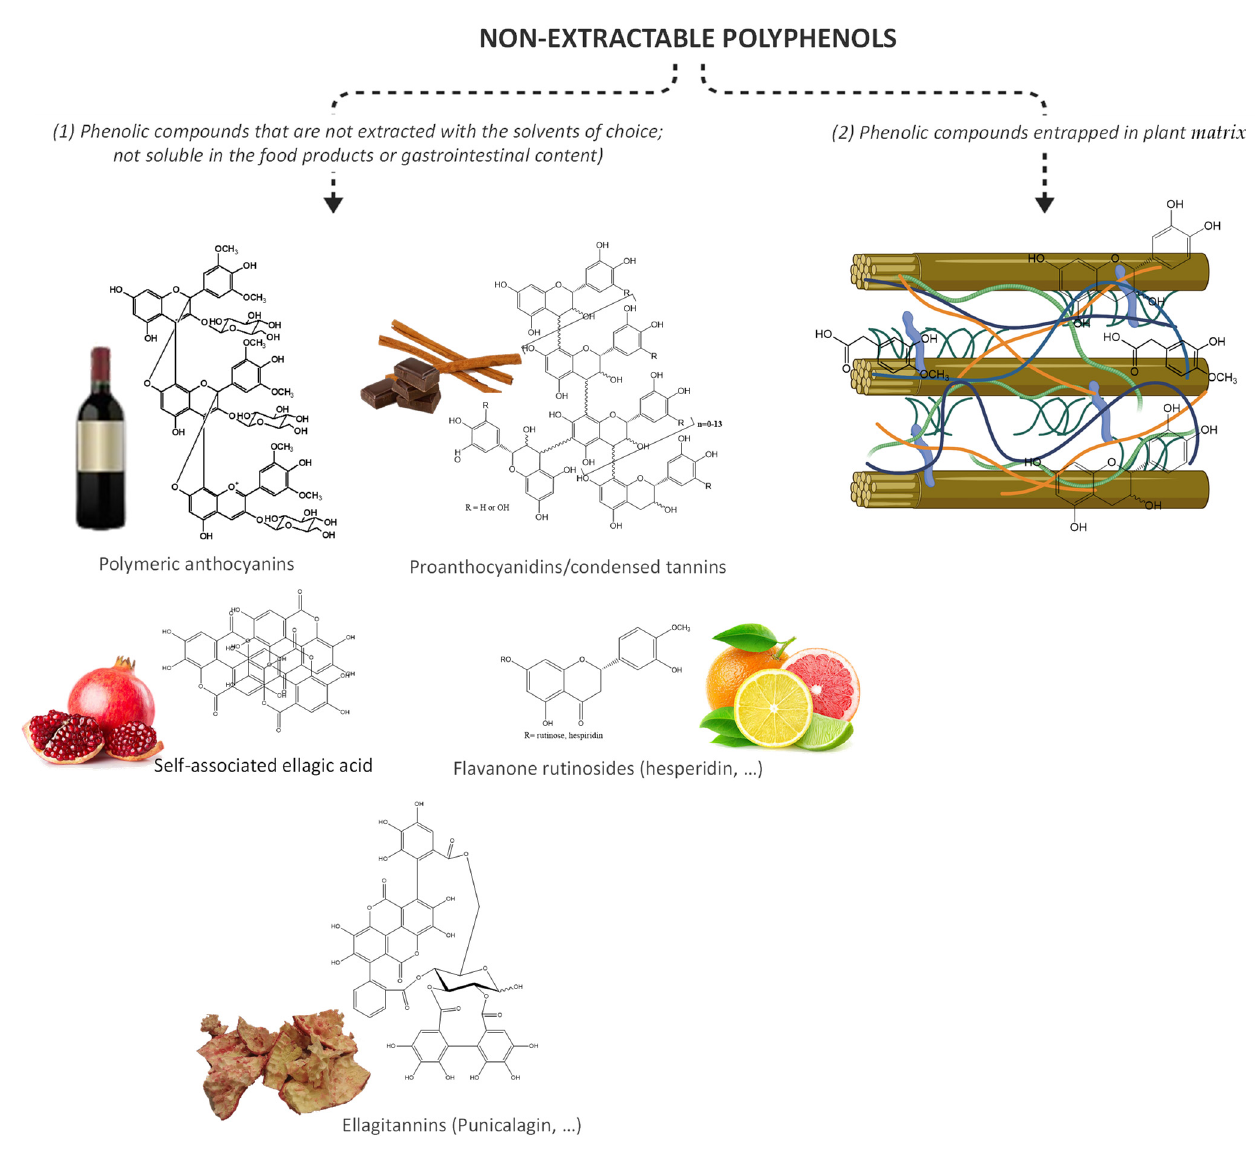
Figure 2. Non-extractable polyphenols, including (1) non-bioavailable polyphenols and (2) complex structures composed by cellulose microfibrils, hemicelluloses (xyloglucans, xylans (arabinoxylans, glucuronoxylan, and glucuronoarabinoxylan), glucomannans, and mixed-linkage glucans), pectins, lignins, bound polyphenols, and proteins.